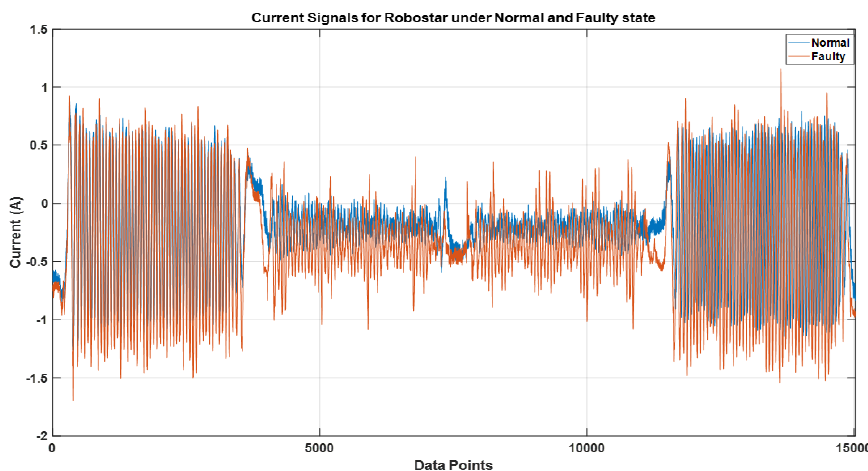
Figure 15. Electric current signal for one cycle of rotation for Robostar.